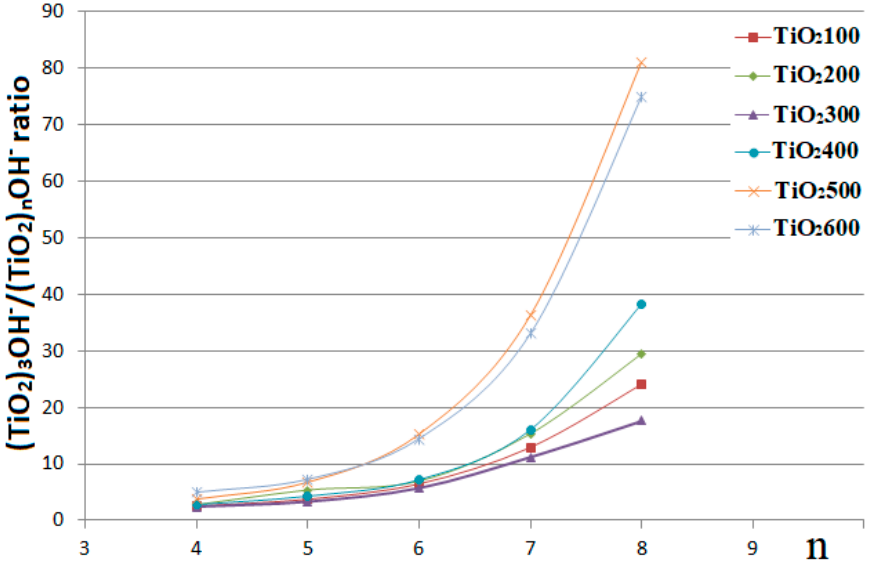
Figure 3. The breakdown plots of the (TiO 2 ) 3 OH − /(TiO 2 ) n OH − ratio against the n number obtained for heated TiO 2 samples..